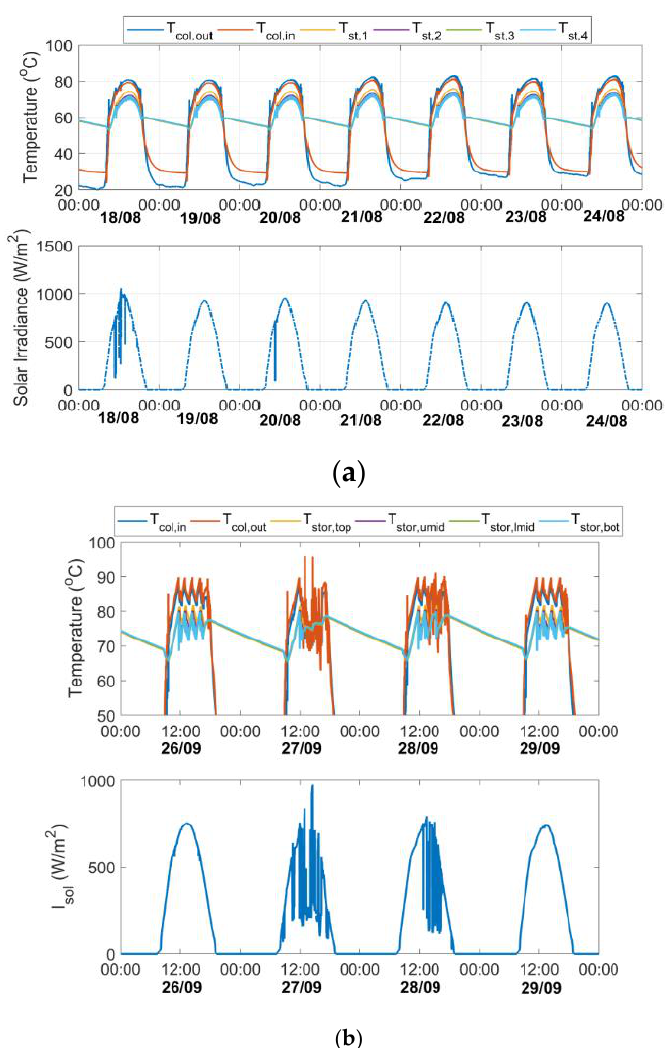
Figure 8. ZEOSOL system behavior on hot summer days ( a ) and on cloudy days ( b ).